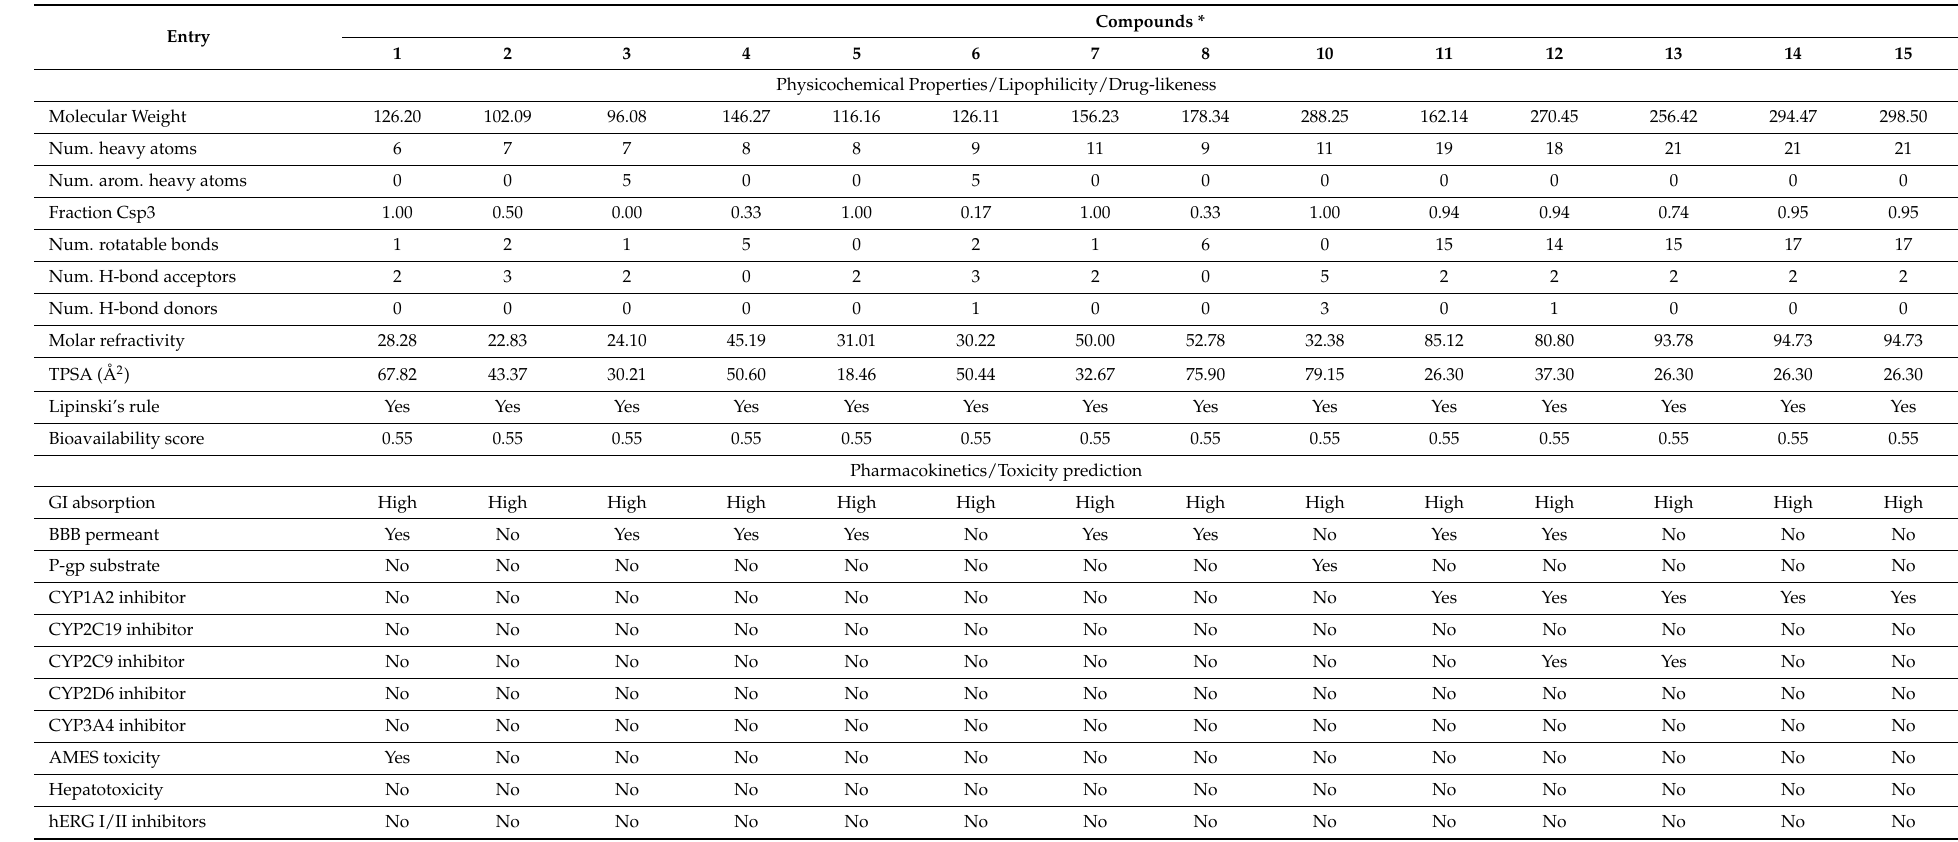
Table 7. ADMET properties of the identified